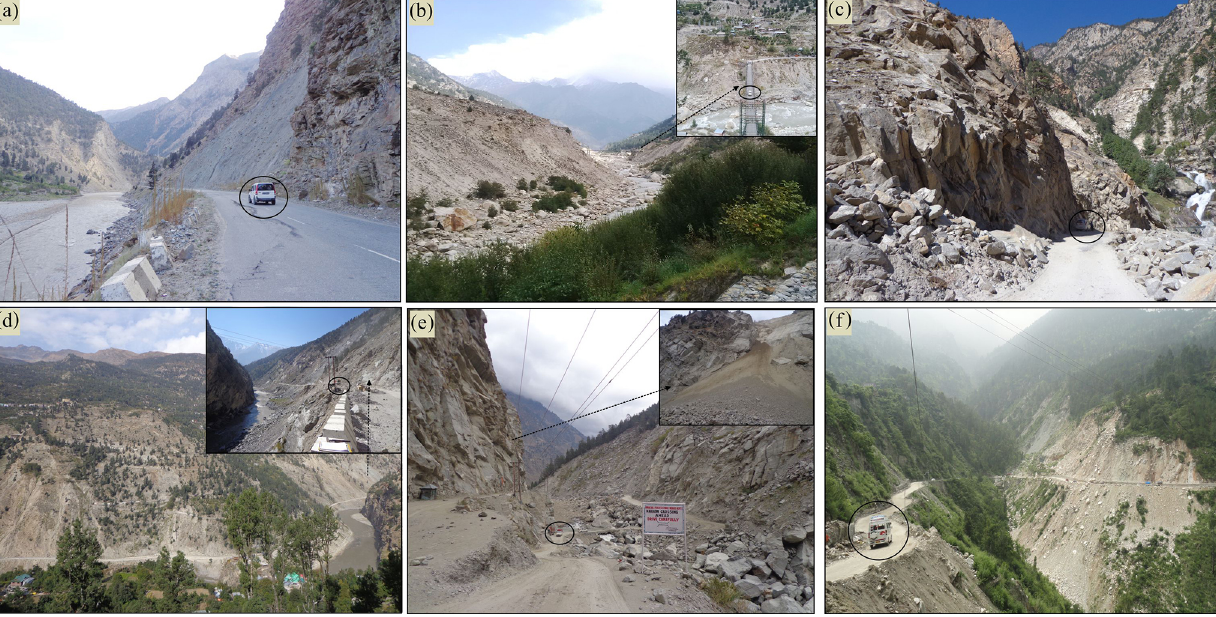
Figure 2. Field photographs of some of the landslides: (a) Khokpa landslide (no. 1), (b) Akpa_III landslide (no. 5), (c) Rarang land- slide (no. 6), (d) Pawari landslide (no. 14), (e) Urni landslide (no. 19), and (f) Barauni Gad_I_S landslide (no. 38). The black circle in the pictures that encircles the vehicle is intended to represent the relative